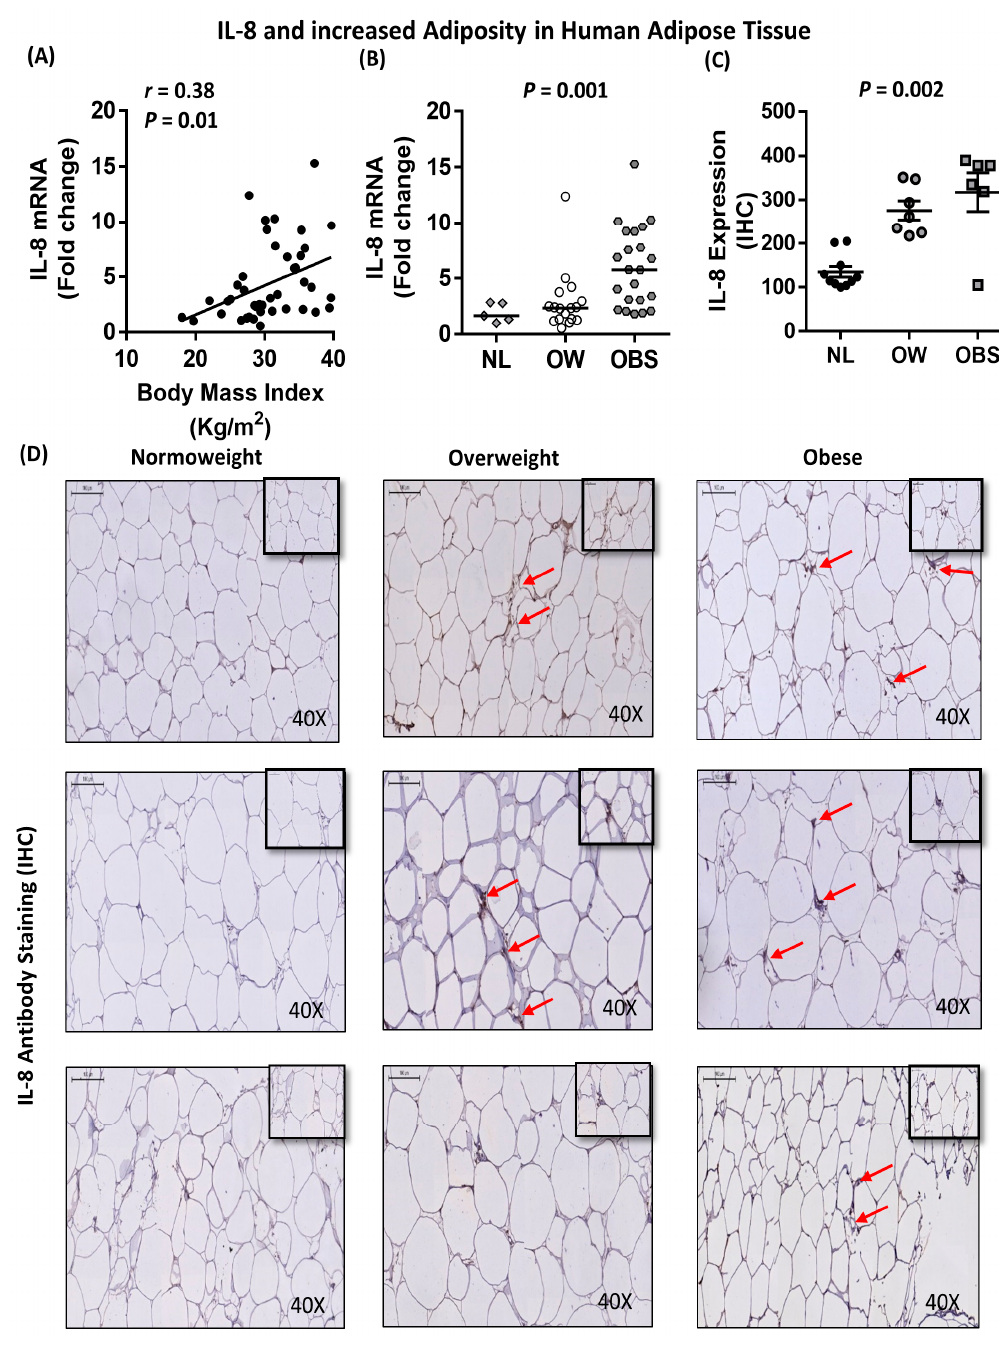
Figure 8. Association between IL-8 and increased adiposity in human adipose tissue. Subcutaneous adipose tissue was obtained from individuals with normoweight, overweight or obesity. ( A ) Direct correlation between adipose tissue IL-8 mRNA expression and the BMI. ( B , C ) Increased adipose tissue IL-8 mRNA and protein expression with increasing adiposity. IL-8 mRNA expression was detected by real-time RT-PCR and represented as fold change over controls. IL-8 protein expression was detected by immunohistochemistry and represented as staining intensity based on Aperio-positive pixel counts (Aperio software algorithm version 9.0). ( D ) Representative images are presented for IL-8 protein expression in the adipose tissue from individuals with normoweight, overweight or obesity. The arrowheads point to cells with intense staining for IL-8 protein. Correlation analysis was conducted using the non-parametric Spearman’s r test, and the group medians were compared using the non-parametric Kruskal-Wallis test.